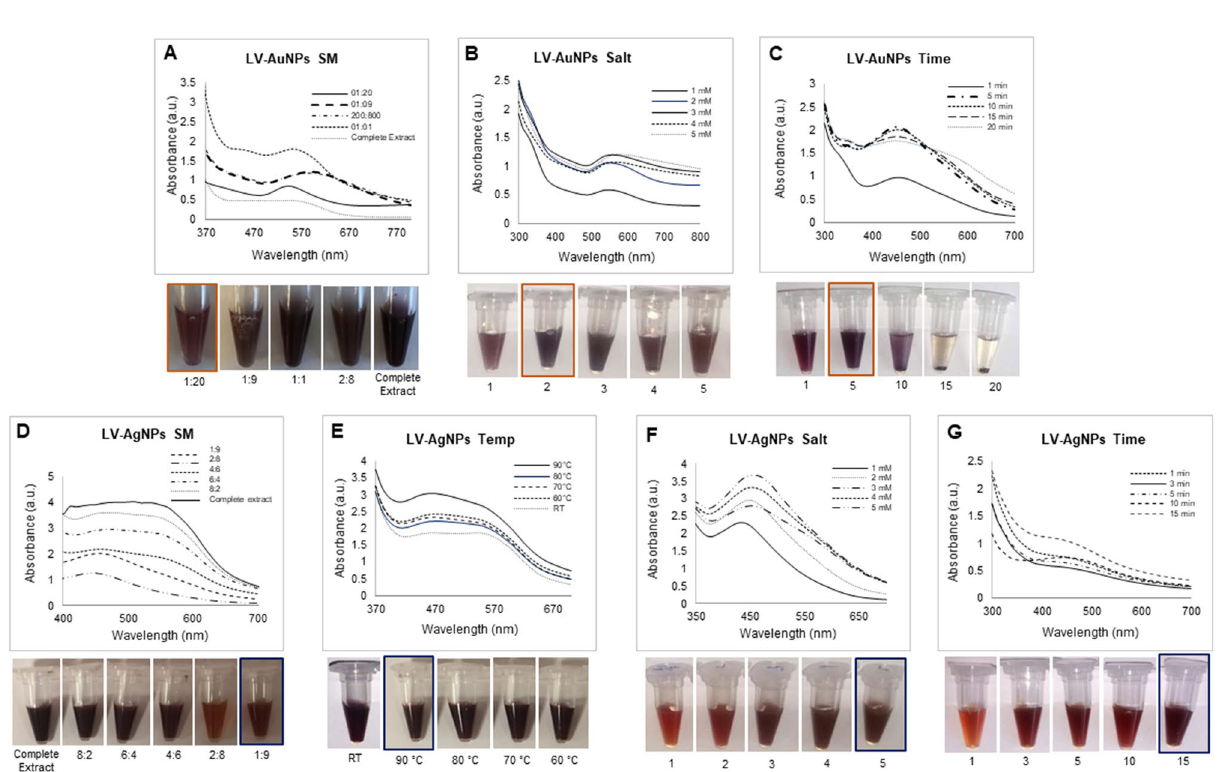
Figure 2. Optimization studies for LV-AuNPs and LV-AgNPs production. For LV-AuNPs production optimization with visible picture and UV-Vis spectrum, (A) synthesis medium; (B) gold salt optimization; (C) time optimization. For LV-AgNPs production optimization with visible picture and UV-Vis spectrum, (D) synthesis medium, (E) temperature, (F) silver slat concentration and (G) synthesis